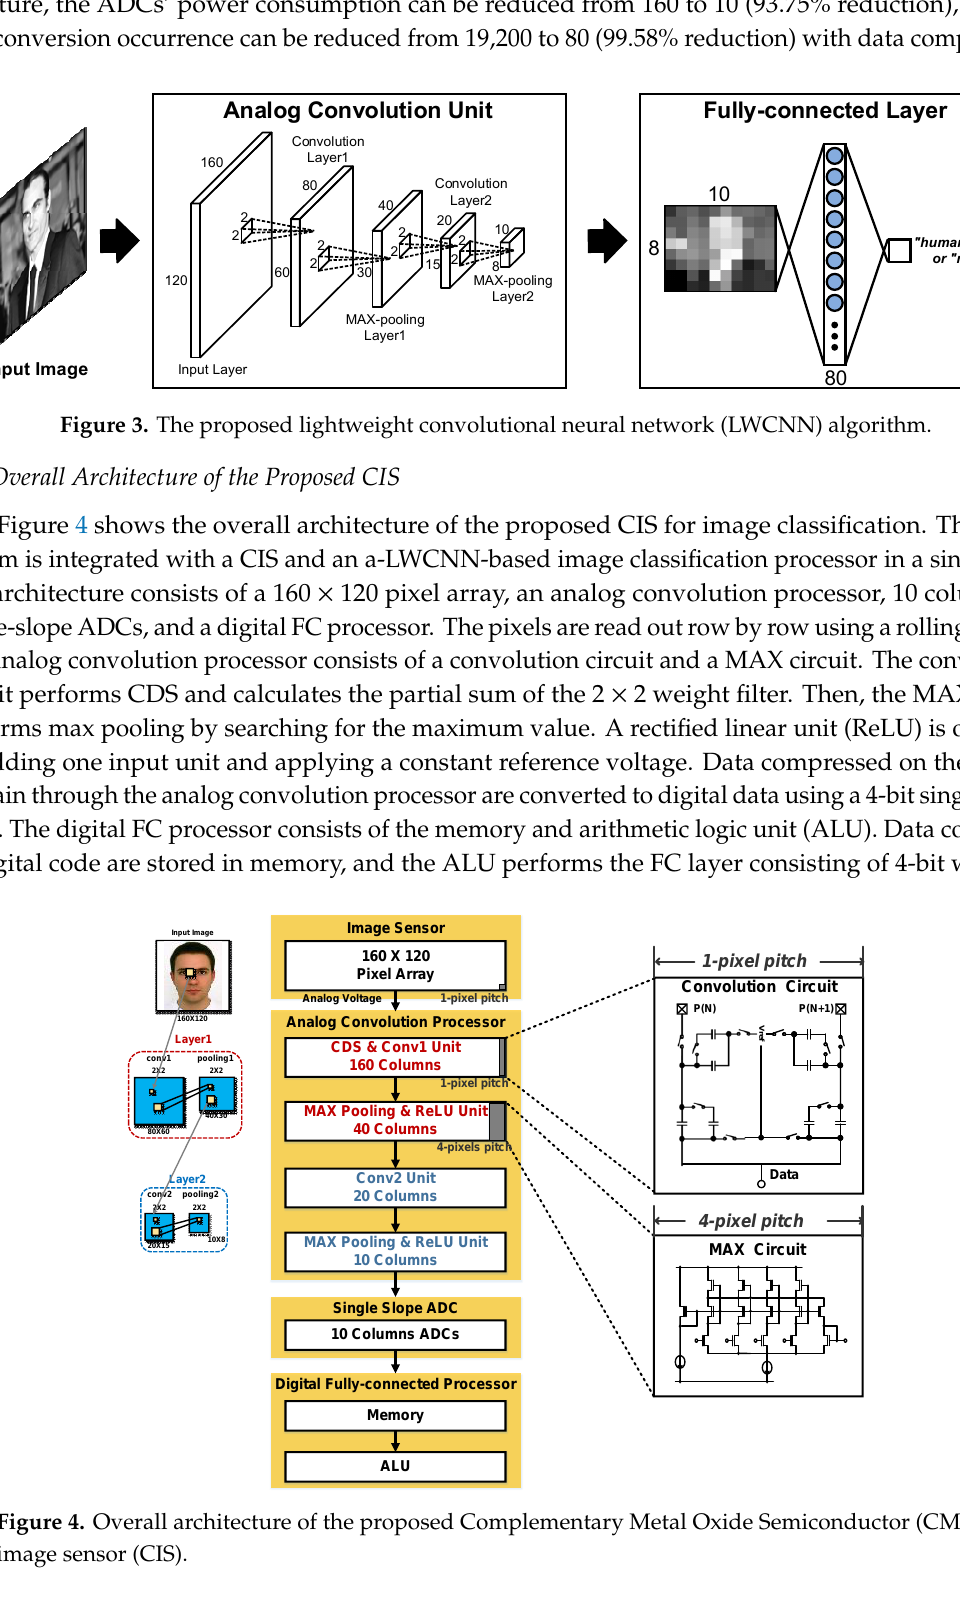
Figure 4. Overall architecture of the proposed Complementary Metal Oxide Semiconductor (CMOS) image sensor (CIS).